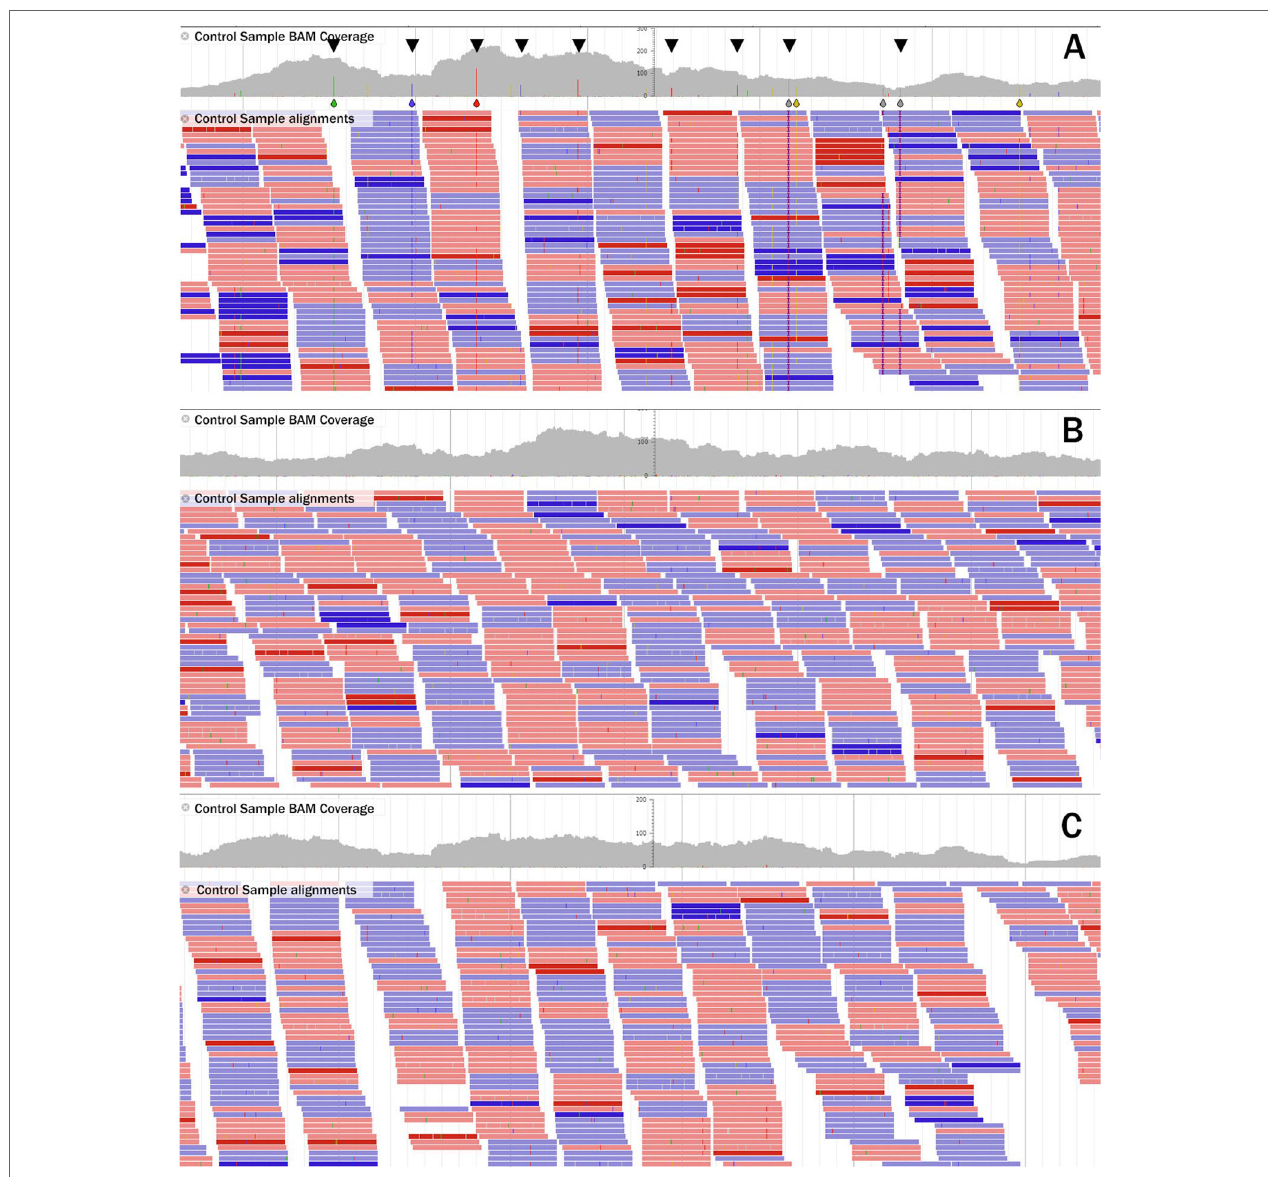
FIGURE 1 | Example of read alignment of the control line to the a 1.37-Kbp region of (A) the Roche NimbleGen exome reference contig05736, (B) to the corresponding regions of contig05736 in DECaR originating from Svevo chromosome 3A, and (C) Svevo chromosome 3B. Reads in red align to the (+) strand, those in blue to the (-) strand. Location of potential mutations/polymorphisms are indicated by blue (cytosine), green (adenine), red (thymine), and yellow (guanine) bars for the DNA base called and highlighted by black triangles in the coverage track in A; in B and C, no mutated bases were